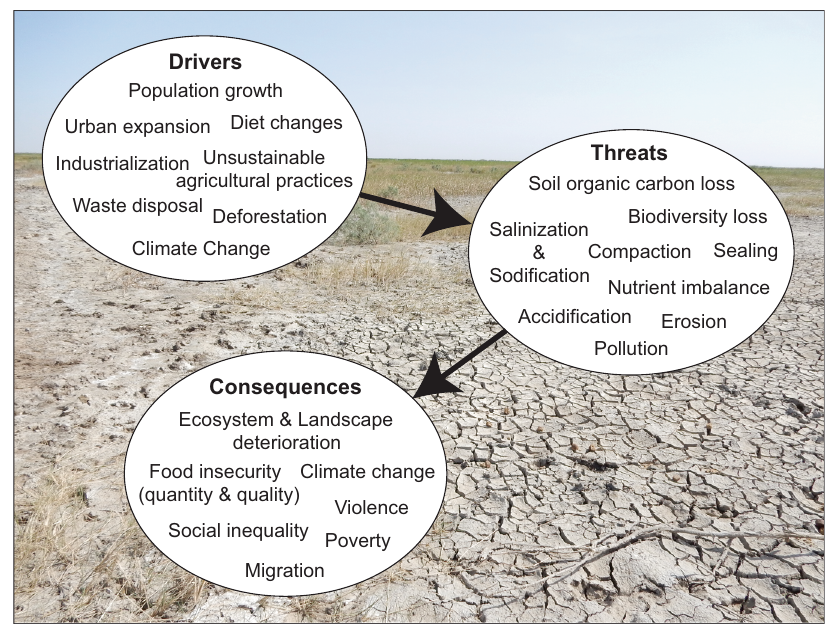
Fig. 1 Soil degradation. The process of soil degradation depicted by the main drivers, quanti fi able threats and the consequences of soil degradation on planetary and societal